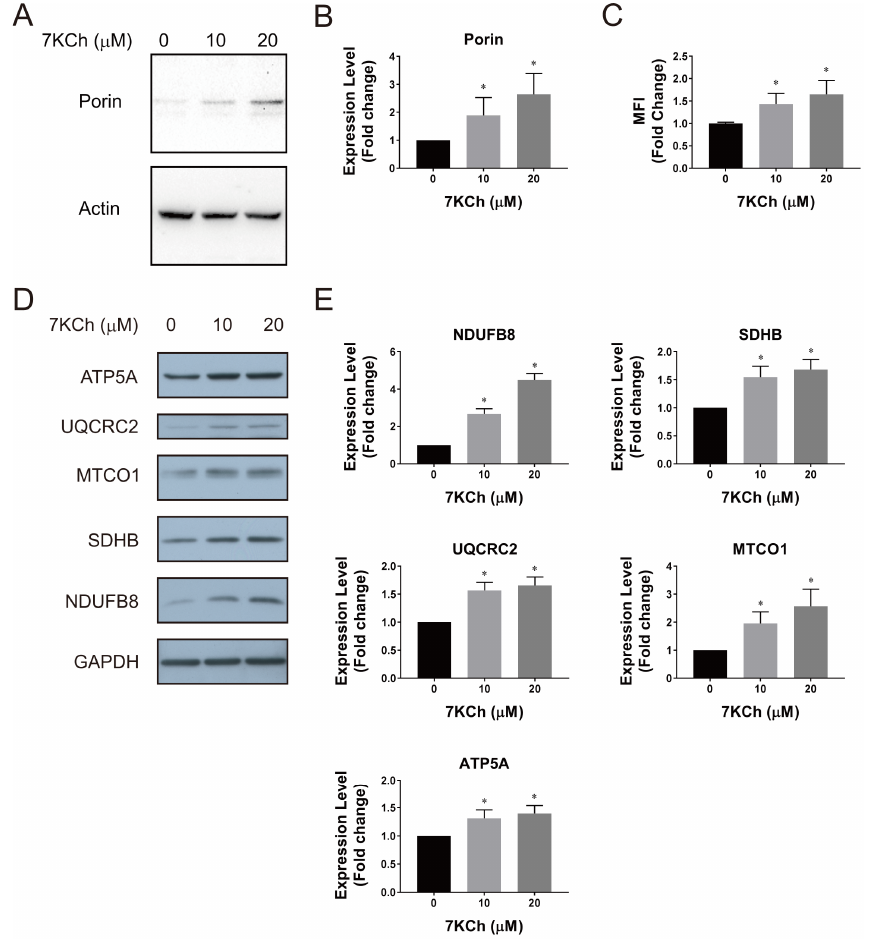
Figure 3. Compensatory mitochondrial biogenesis is induced by 7KCh. ( A , B ) HL-1 cells were treated with the indicated concentrations of 7KCh and analyzed for the expression of porin and actin by immunoblotting with respective antibodies. A representative of three experiments is shown. The band intensities of porin and actin were quantified. The band intensity of porin was normalized to that of actin and is expressed as the fold change relative to the 0 μ M 7KCh treatment group. Data are mean ± SD of three experiments. * p < 0.05 vs. the 0 μ M 7KCh treatment group. ( C ) Cells were similarly treated, and the mitochondrial mass was analyzed by MitoTracker Green staining and flow cytometric analysis. The MFI of the MitoTracker Green-stained cells is expressed as the fold change relative to that of the untreated control. Data are mean ± SD, N = 9. * p < 0.05 vs. the 0 μ M 7KCh treatment group. ( D , E ) Expression of characteristic respiratory complex proteins. HL-1 cells were treated with the indicated concentrations of 7KCh, and analyzed for expression of NDUFB8, SDHB, UQCRC2, ATP5F1A, MTCO1, and glyceraldehyde-3-phosphate dehydrogenase (GAPDH). A representative of three experiments is shown. The band intensities of various proteins were quantified. The band intensities of these proteins are normalized to that of GAPDH, and expressed as the fold change relative to the 0 μ M 7KCh treatment group. Data are mean ± SD of three experiments. * p < 0.05 vs. the 0 μ M 7KCh treatment group.